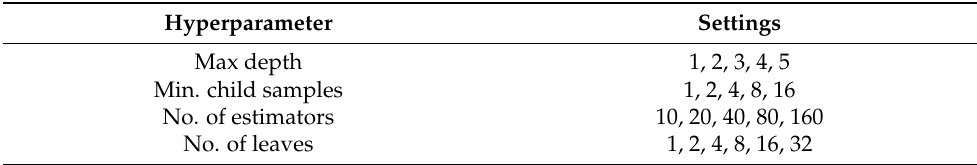
Table 3. Configurations and hyperparameter settings used in the